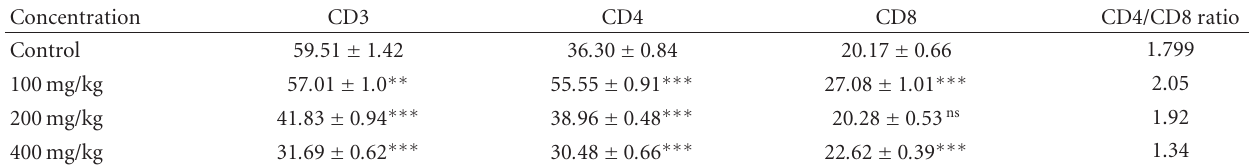
Table 7: Table showing the e ff ect of PST001 on lymphocyte subsets.